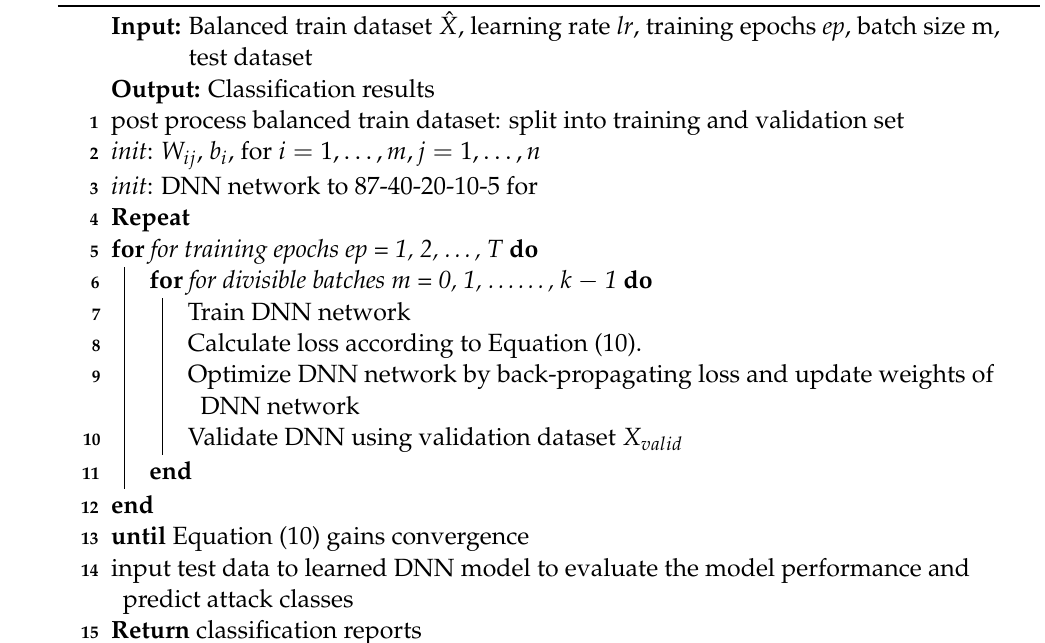
Algorithm 3: DNN